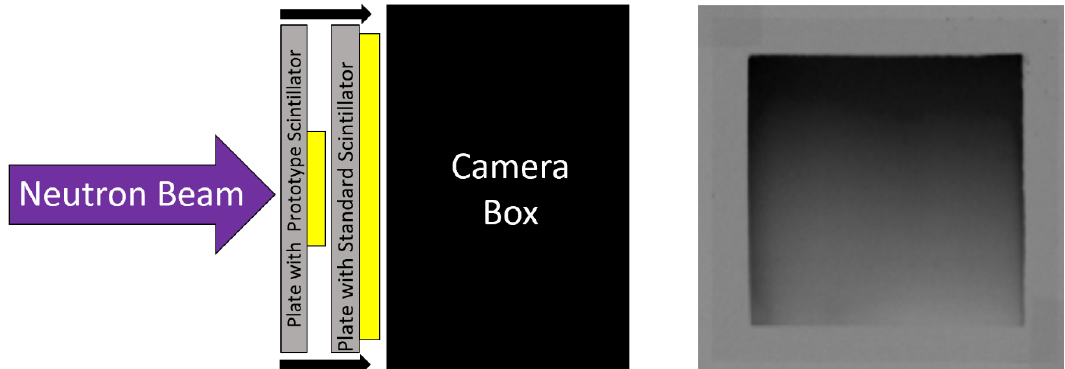
Figure 4. (Left) Diagram of the setup for a detection efficiency measurement. The test-screen is radiographed by a standard neutron scintillator screen that is optically coupled to the camera. (Right) A neutron radiograph taken with a commercial scintillator screen of a wedge-type 6 LiF:ZnS scintillator screen.